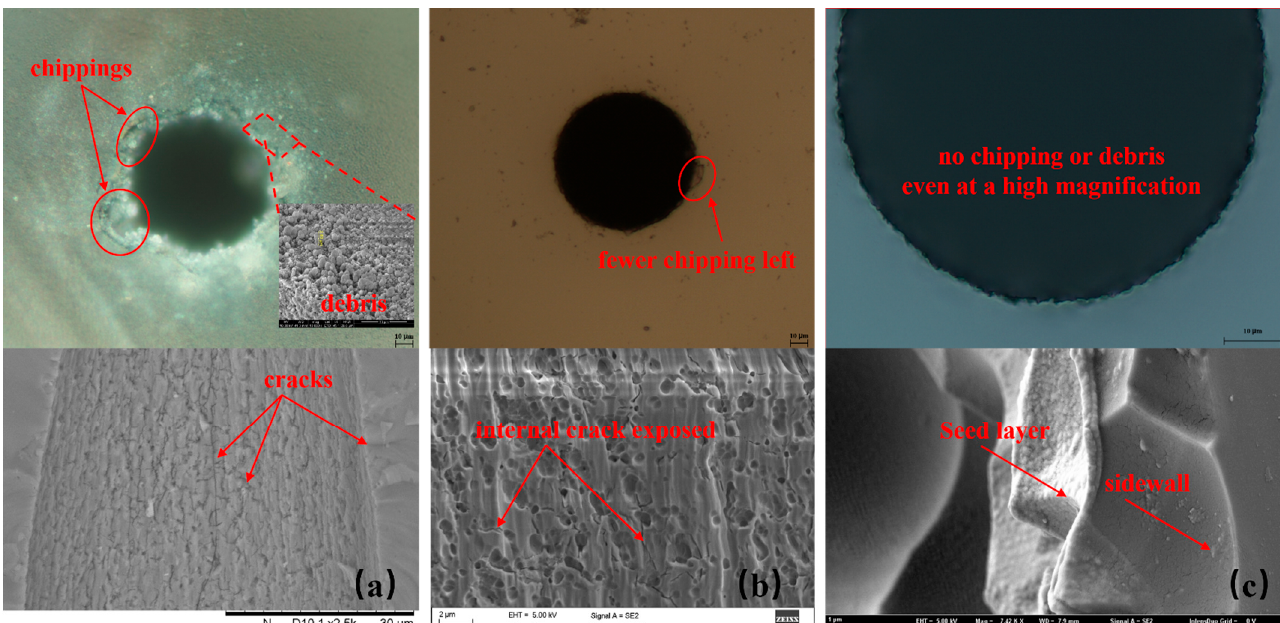
Figure 5. Processes of via formation. ( a ) is the morphology after picosecond laser drilling. ( b ) is the observed picture after ultrasonic cleaning and wet etching. ( c ) is a topographic picture after complete wet etching. It can be observed that after seed layer sputtering, the metal fits well with the sidewall and there is a strong continuity of the